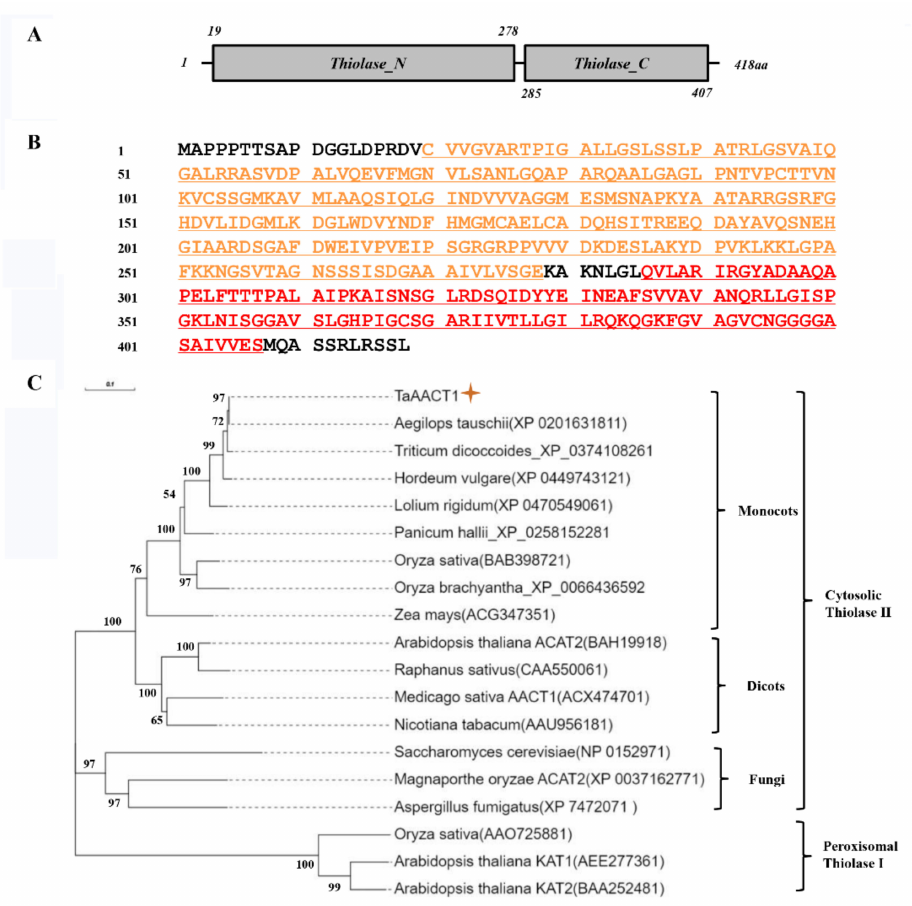
Figure 3. Sequence and phylogenetic analyses of TaAACT1 protein and 18 other thiolase proteins from other plant species and fungi. ( A ) Schematic diagram of two domains of TaAACT1 protein. ( B ) Sequence of TaAACT1 protein. The orange part indicates Thiolase-N domain. The red part indicates Thiolase-C domain. ( C ) The bootstrapped phylogenetic tree is constructed using the neighbor-joining phylogeny of MEGA 11.0. The scale represents the branch length, and each node reresents bootstrap values from 1000 replicates. † indicates the target protein; The bar (0.1) indicates 10% dissimilarity and distance scale can display the degree of